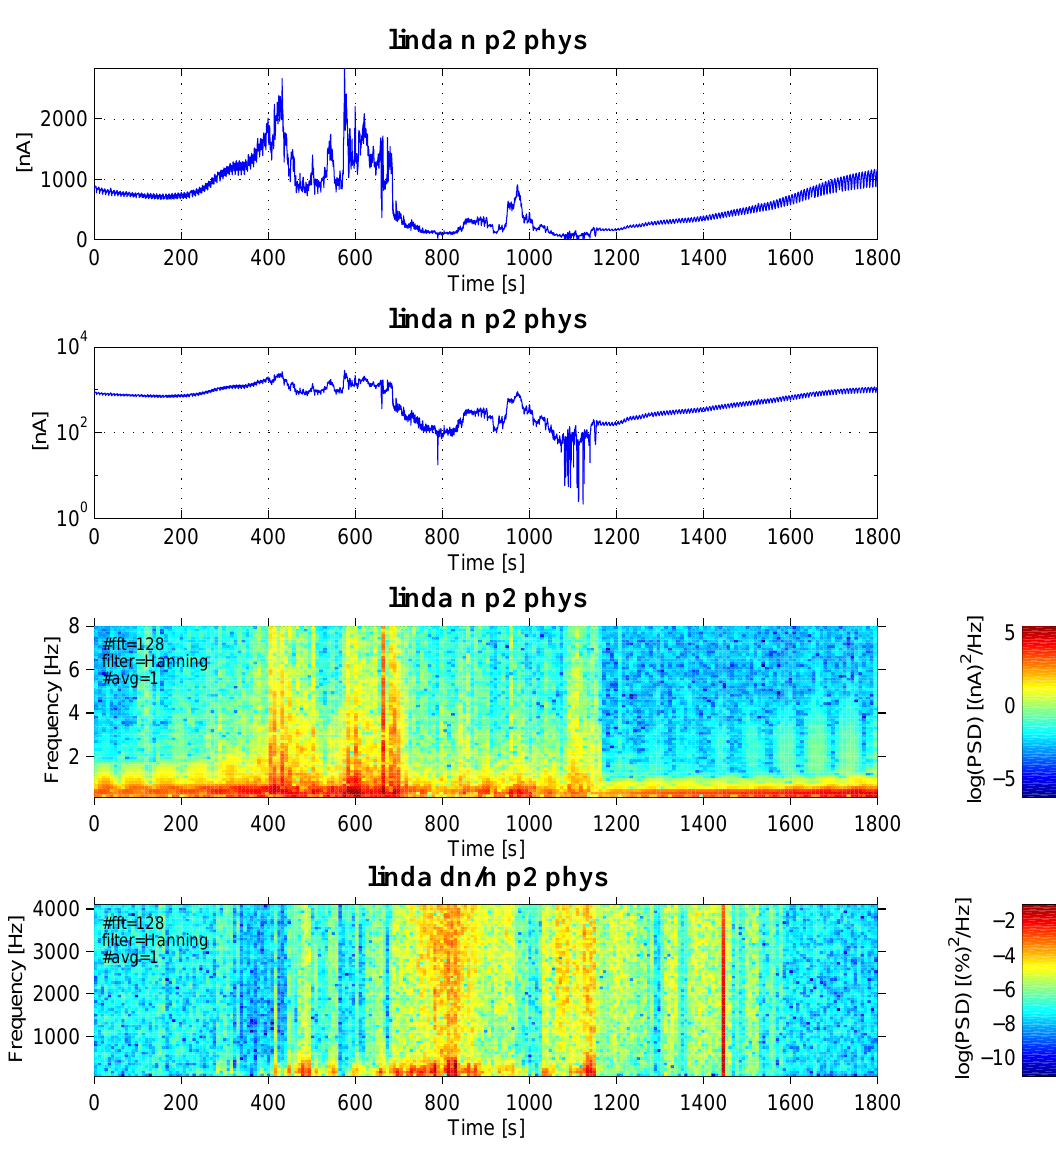
Fig. 2. A blow-up of the event in Fig. 1 showing 30 minutes of data from the southern auroral oval and polar cap regions. A spectrogram of the 1I/I quantity up to 4 kHz has been added (lowest panel), showing broadband emissions filling the large scale auroral cavity (e.g. Wahlund et al.,